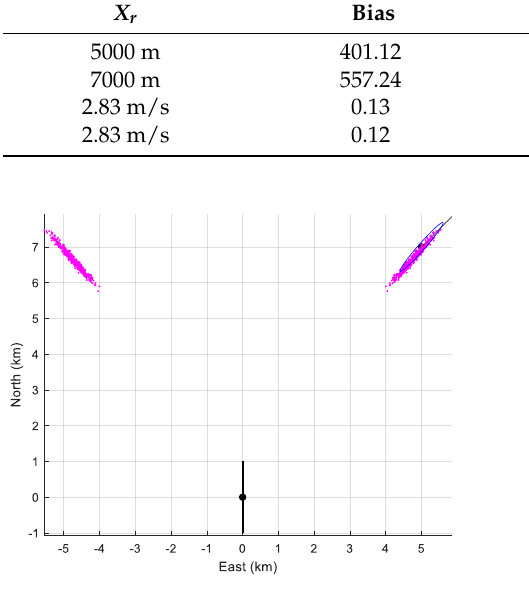
Table 5. Performance of the estimator of the reduced state vector. X r